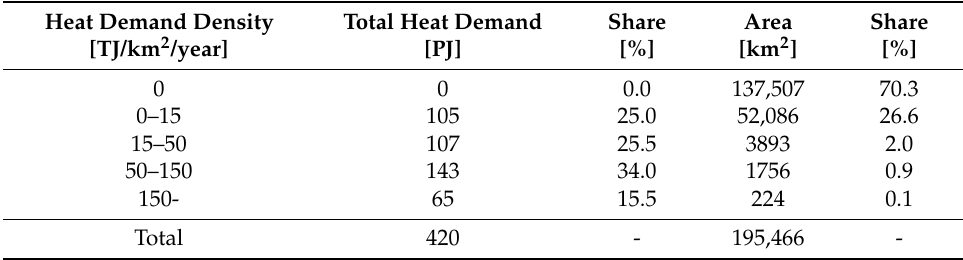
Table 2. Classification of heat demand density in ten